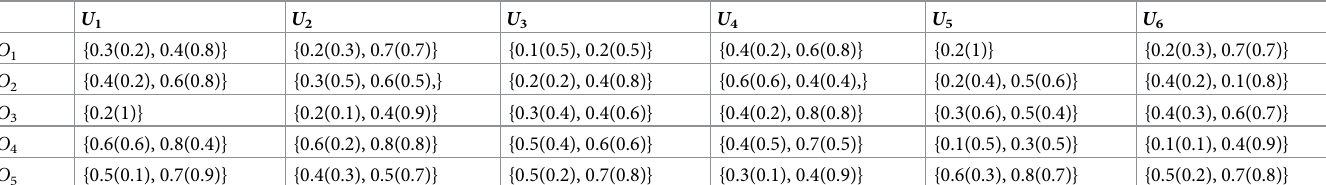
Table 1. PHF matrix R 1 given by the first expert.